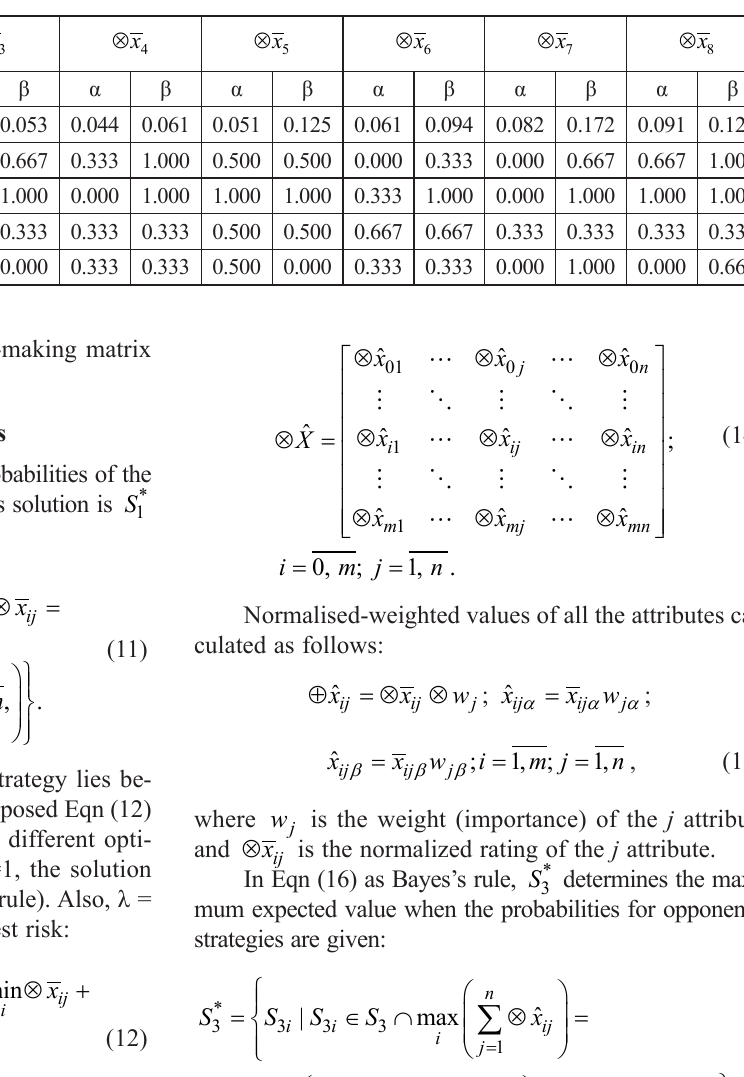
Table 6. The normalized alternative-criteria